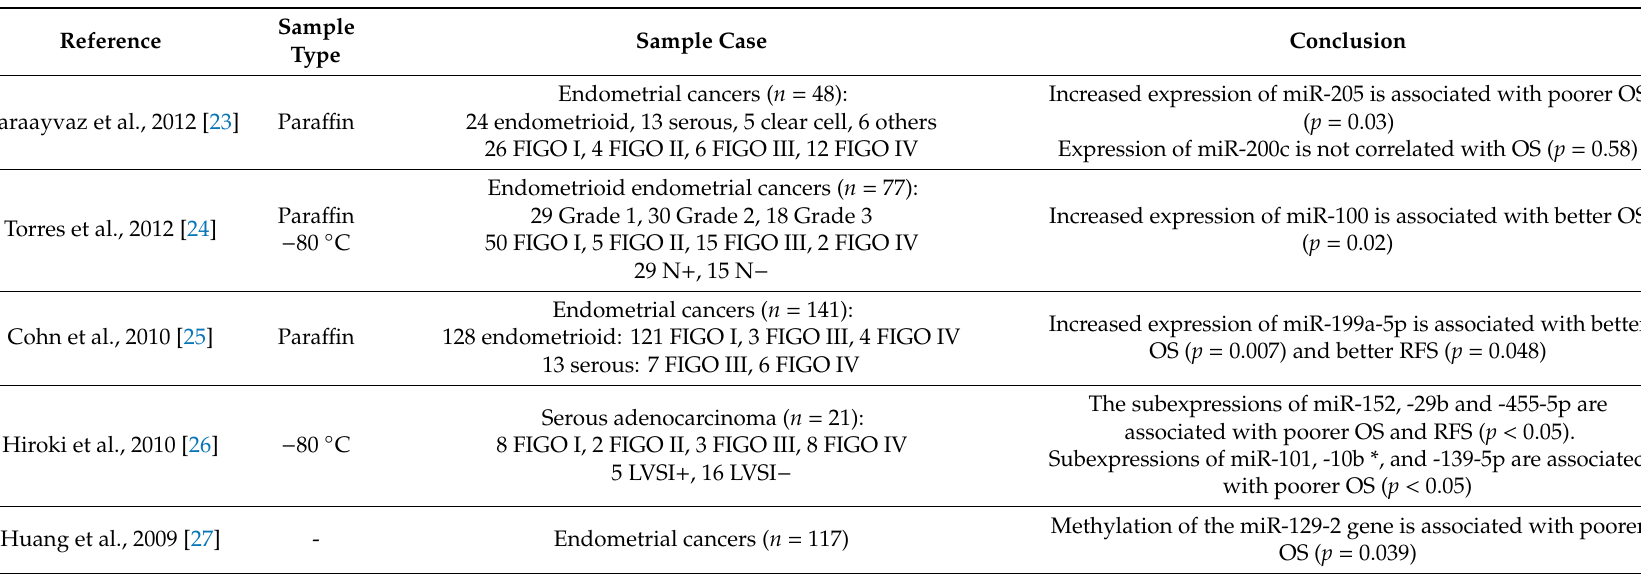
FIGO: International Federation of Gynecology and Obstetrics, LVSI: lympho-vascular space involvement, N: ganglionic status, OS: overall survival, RFS: recurrence-free survival, HR: Hazard